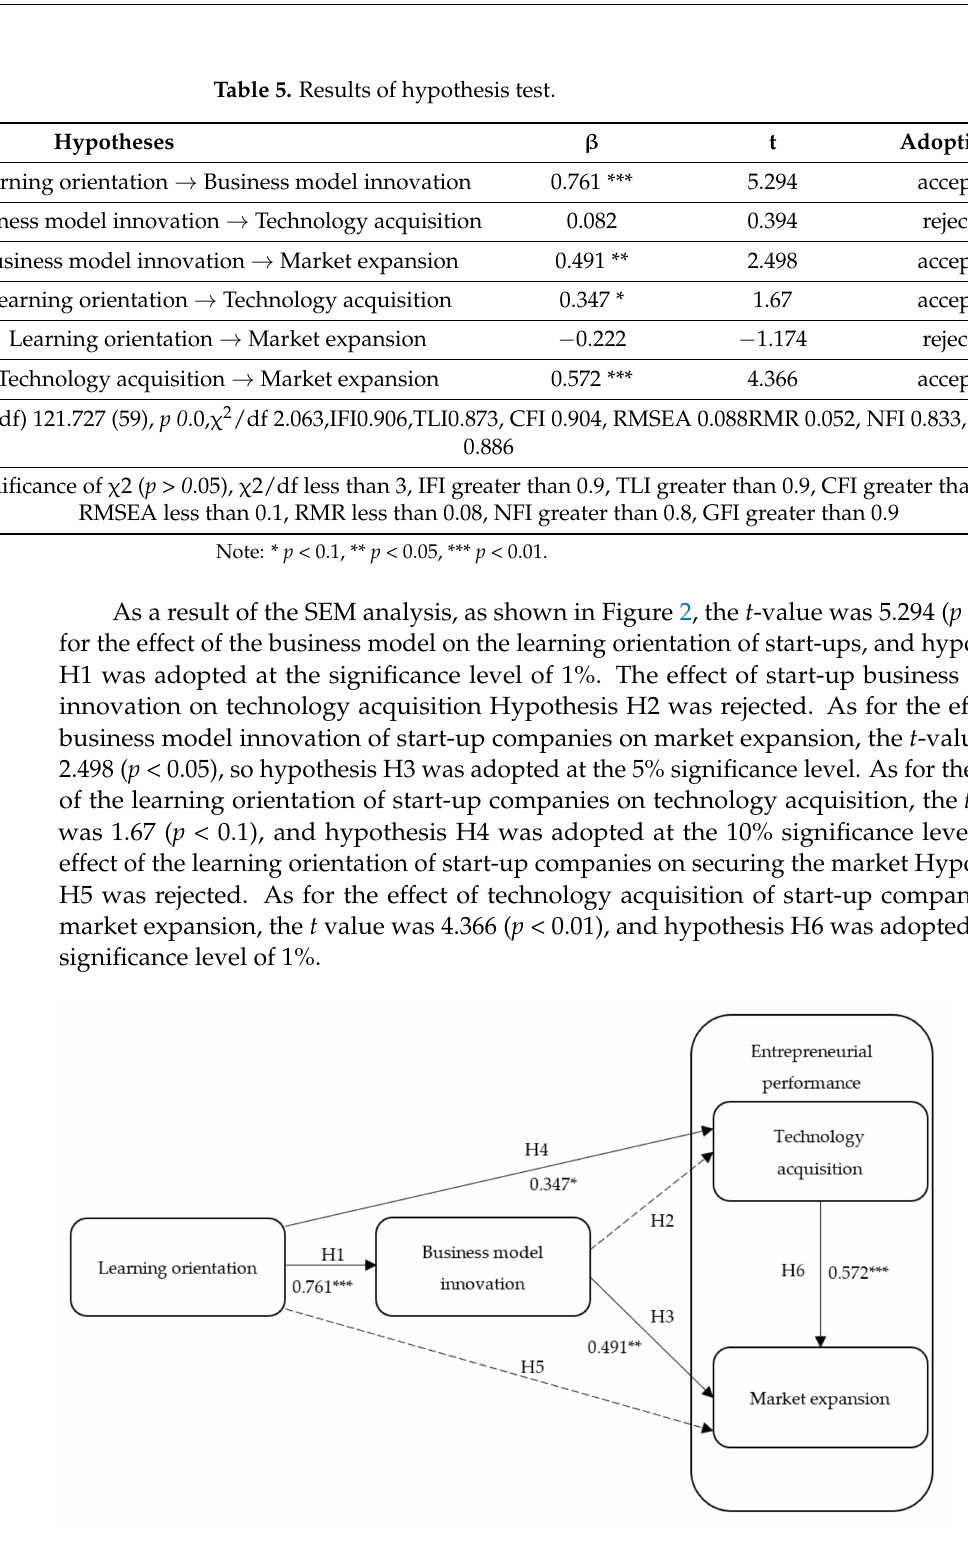
Figure 2. Results of the Research model. * p < 0.1, ** p < 0.05, *** p <